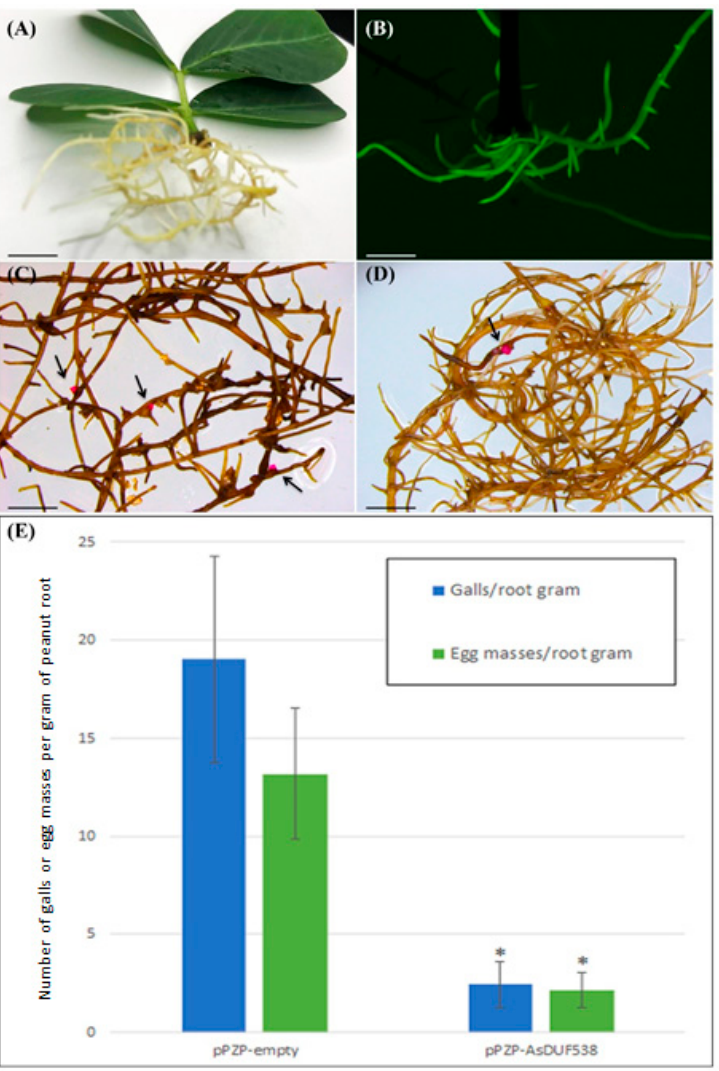
Figure 3. Meloidogyne arenaria infection analysis in peanut hairy roots. Transgenic peanut hairy roots transformed with pPZP-empty observed in the stereomicroscope using ( A ) bright field and ( B ) epifluorescence. Transgenic peanut hairy roots transformed with ( C ) pPZP-empty and ( D ) pPZP-AsDUF538 at 60 days after M. arenaria inoculation. Arrows indicate egg masses. ( E ) Mean number of galls and egg masses per gram of root (± standard deviation) in peanut hairy roots transformed with pPZP-empty and pPZP-AsDUF538. Statistical analyses were performed using the t -test and asterisks indicate significant differences ( p < 0.05). Bars = 5 mm.